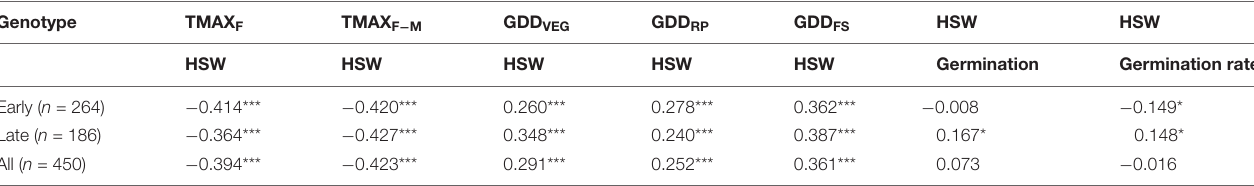
TABLE 2 | Pearson correlation coefficient ( r ) between selected parameters.